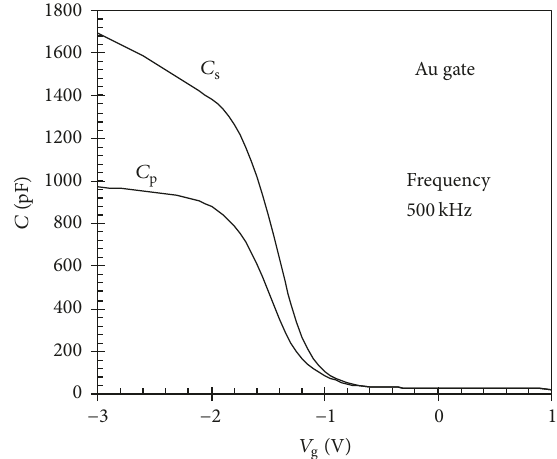
Figure 13: Comparison of 𝐶